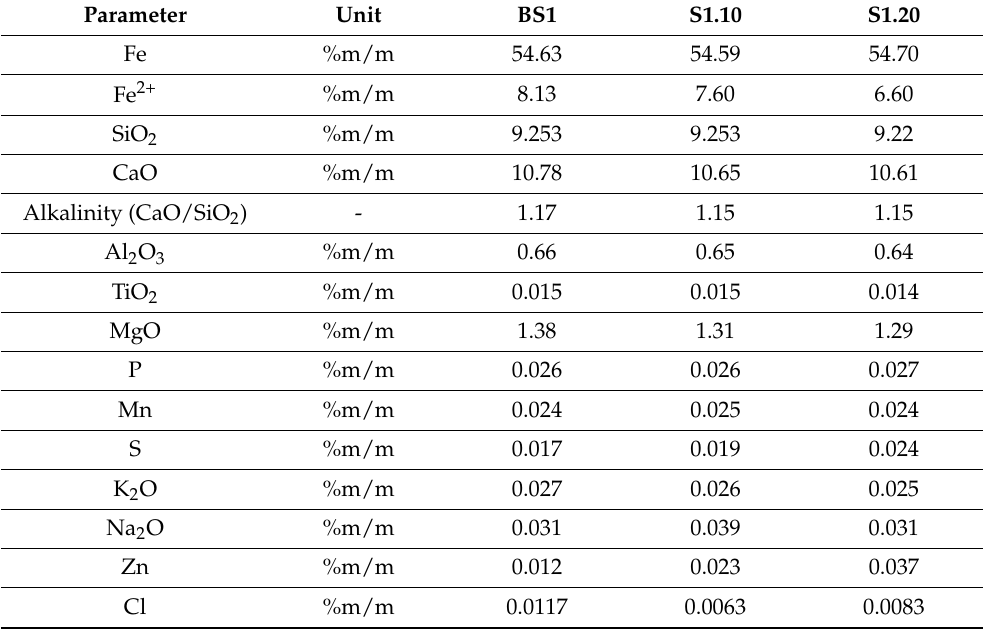
Table 7. Average results of chemical analysis for sinter with TC1 in comparison to BS1 basic sinter.